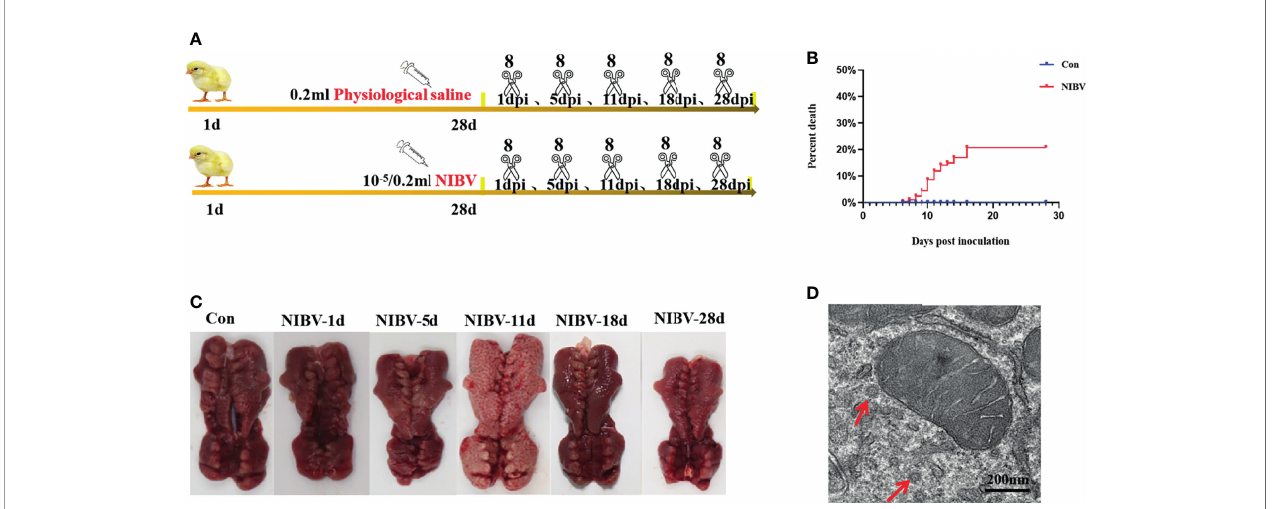
FIGURE 1 | Changes of kidney in chickens infected with nephropathogenic infectious bronchitis virus (NIBV) SX9 strain (10 -5 /0.2 ml). (A) Experimental design. Including electron microscope and pathological section were observed, as well as RT-qPCR, western blot and confocal immuno fl uorescence analysis; (B) Mortality rate of 1 dpi-28 dpi chickens infected with NIBV; (C) Renal necropsy observation; (D) Ultrastructural of renal tissue, the red arrow points to the virus